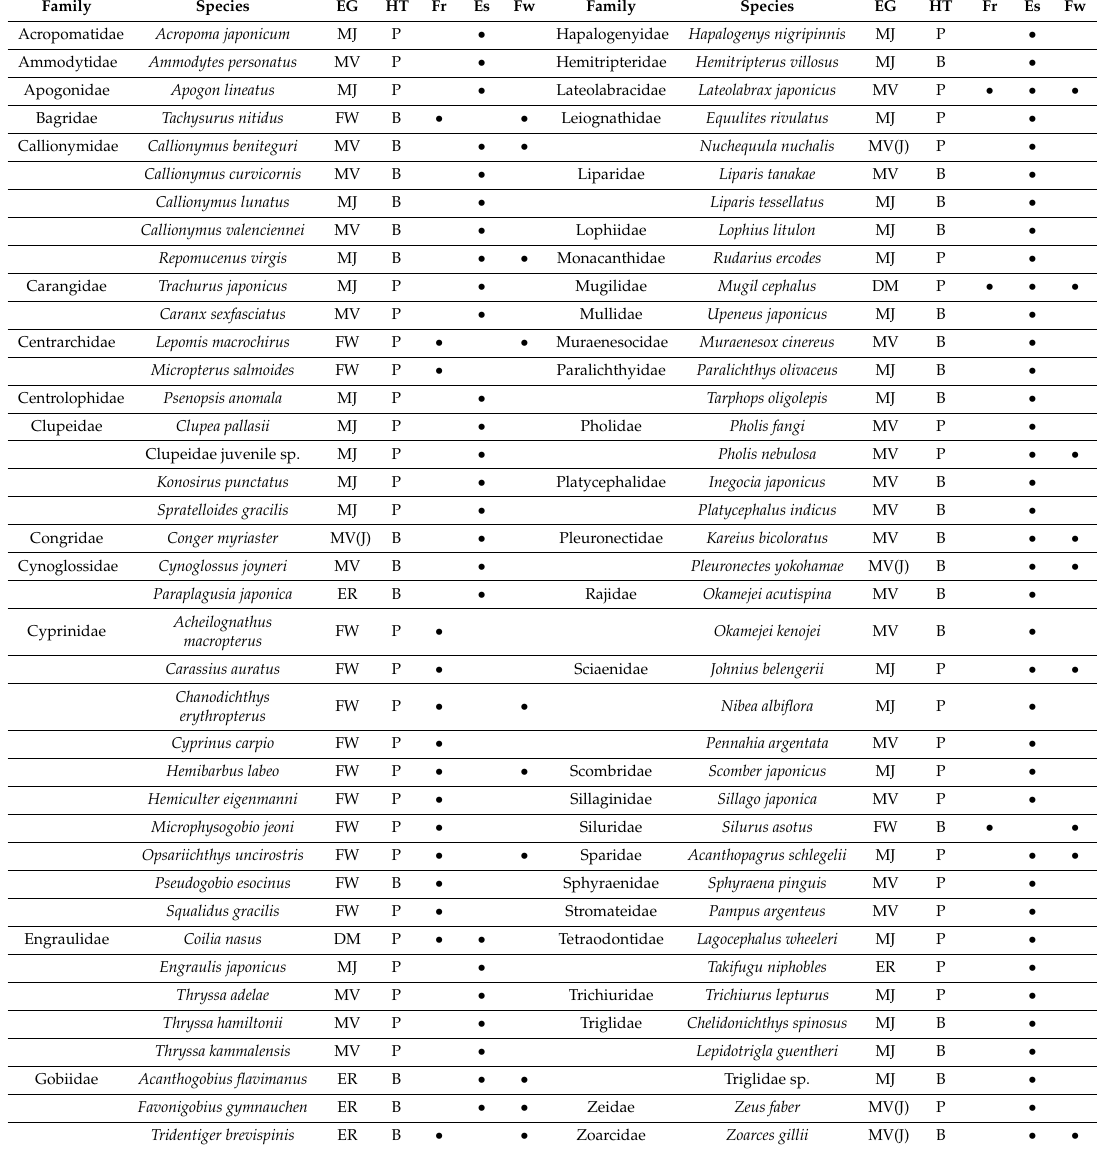
Table 1. List of fish species, ecological guild (EG), habitat type (HT), and occurrences of fishes in freshwater (Fr), estuarine habitats (Es), and estuary weir fishway (Fw) stations in the lower Nakdong River, South Korea; ER = estuarine residents, FW = freshwater species, MV = marine occasional visitors, MV(J) = MV included juveniles, MJ = marine juvenile, DM = diadromous migrants; B = benthic, P =